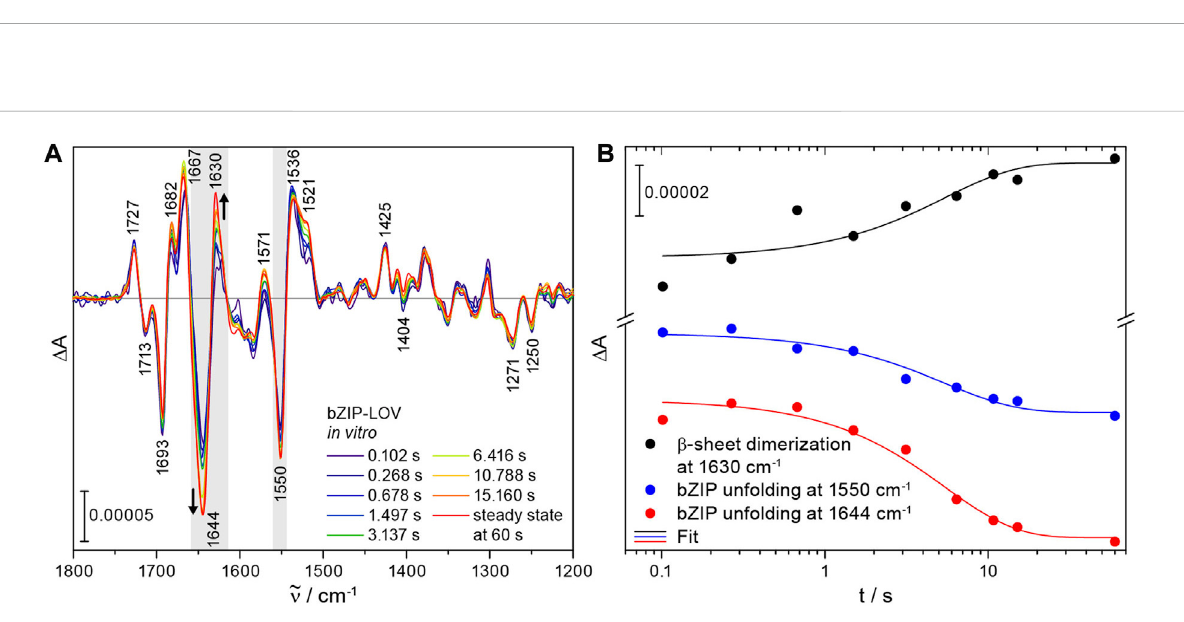
Time-resolved difference spectra of bZIP-LOV from 102 ms to 15 s were obtained by recording intensity spectra before and after excitation with a 10 ns laser pulse at 355 nm. Most signals remained constant in this time range and are attributed to the photoconversion of fl avin to the adduct in LOV. Characteristic bands of fl avin were observed at 1727 (+), 1713 ( − ), 1425 (+), 1271 ( − ) and 1250 ( − ) cm − 1 (Figure 3A) [33,34]. Other signals show a strong increase in intensity on the time scale of seconds and fi nally